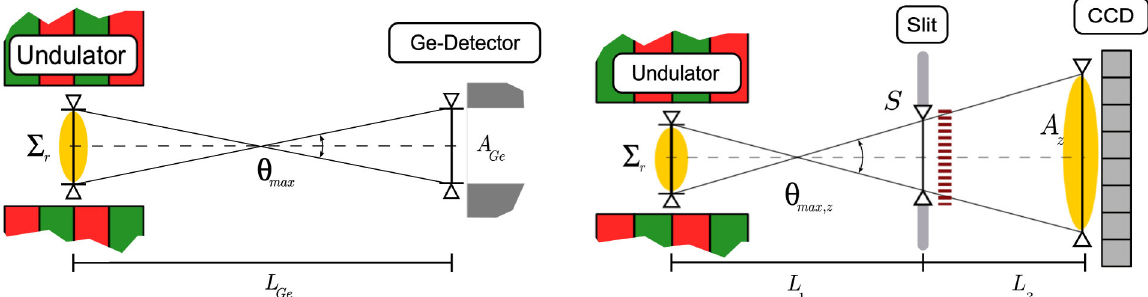
FIG. 2. Experimental setup: Two independent detector systems were used, a Ge-detector (left) and a transmission grating spectrometer (right). In both figures the radiation source size is represented by Σ angle. The transmission grating spectrometer on the right-hand side has an entrance slit of size S which restricts the angle of incidence θ to optimize the spectral resolution. The distances are represented by L . max ;z